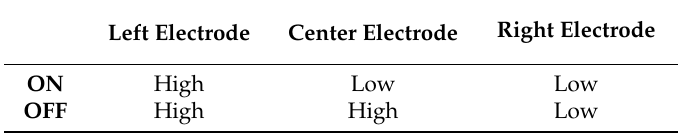
Table 2. Applied control signals of movable triple electrodes actuator.